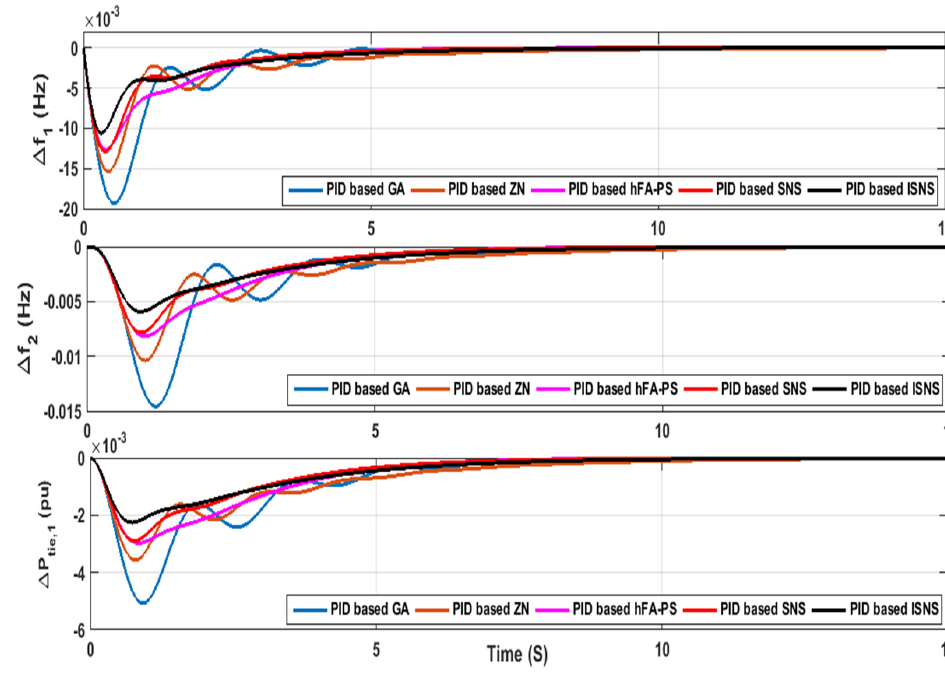
Figure 14. The system under consideration performance for scenario 1.